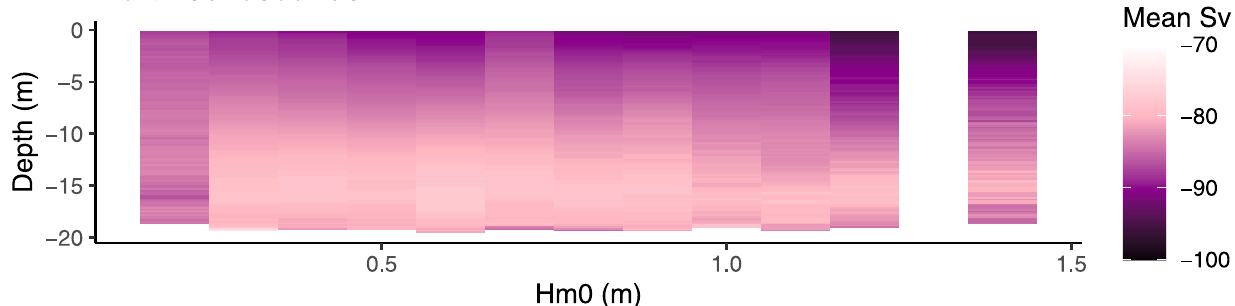
Fig 12. Depth and dispersal of fish over wave height (Hm0) in weak current. The left and right panels are the south and north echo sounder. Data where current exceeded 0.11 m s -1 are excluded. Signal strength ( S v ) indicates fish density with higher values (-70) indicating many fish and lower values (-100) indicating fewer fish. Data presenting shoal depth during the day not included for